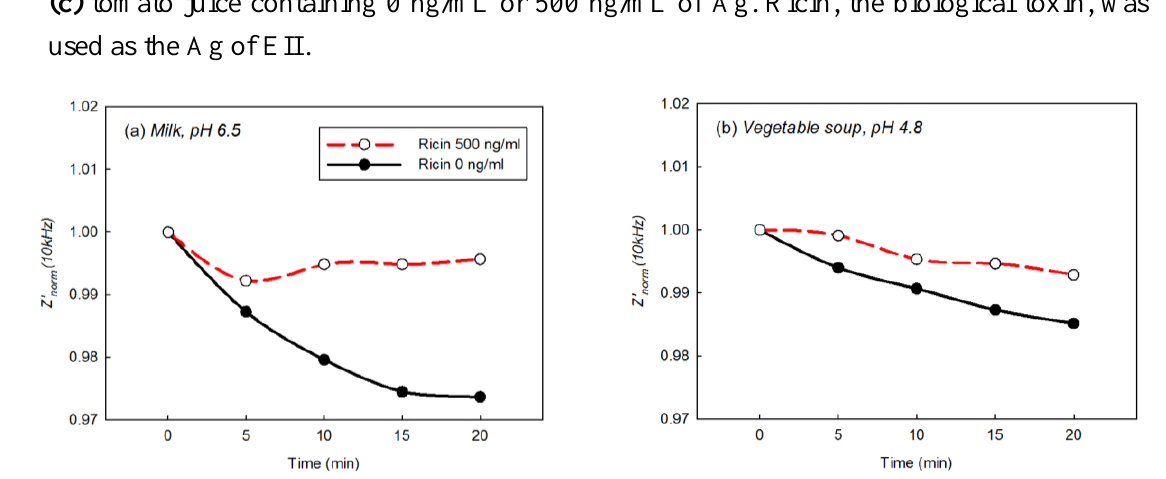
Figure 9. Z’ (10 kHz) from EIS analysis of EII in (a) milk, (b) vegetable soup, and norm (c) tomato juice containing 0 ng/mL or 500 ng/mL of Ag. Ricin, the biological toxin,